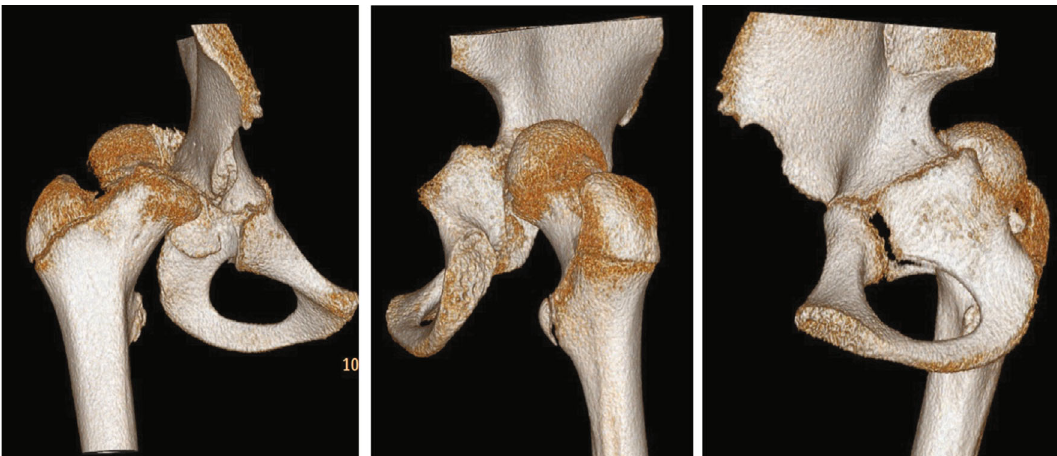
Figure 2: Three-dimensional CT reconstruction images demonstrating the displaced right capital femoral epiphysis and disrupted right acetabular posterior column.